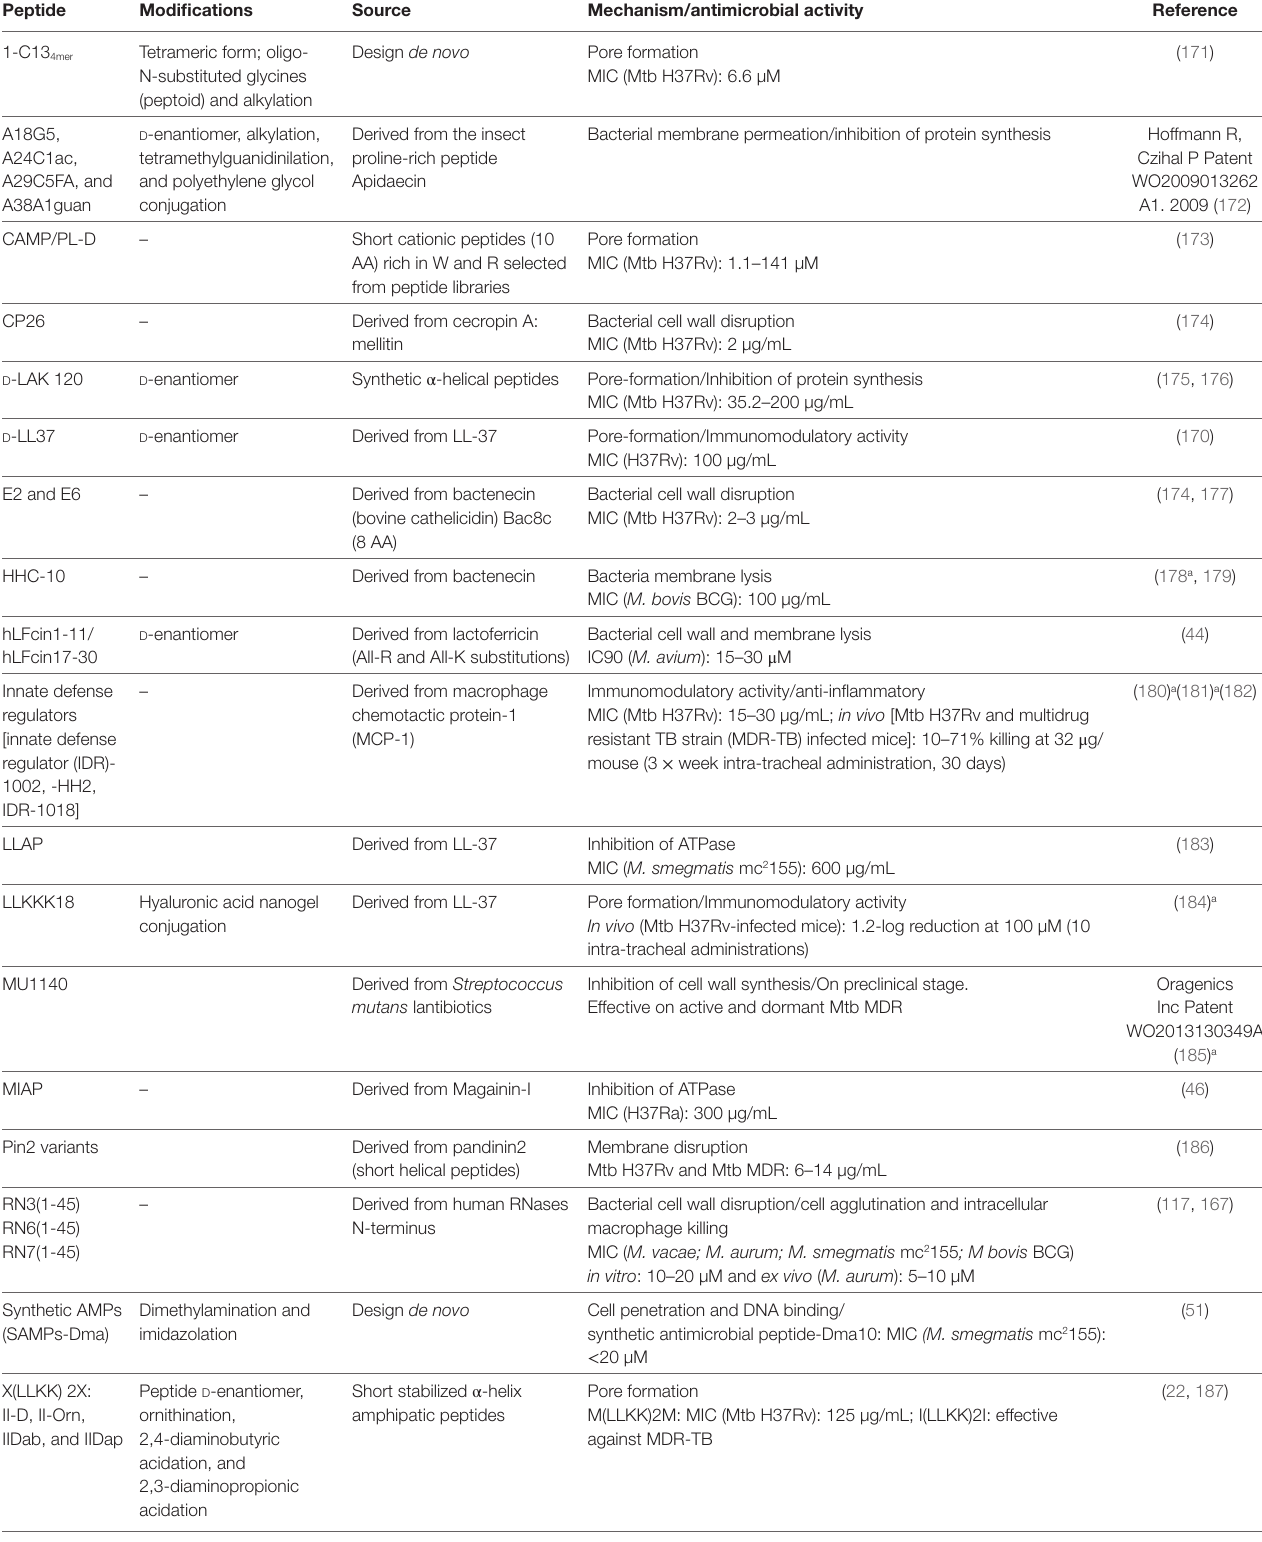
TABLe 2 | Synthetic peptides effective against mycobacteria.